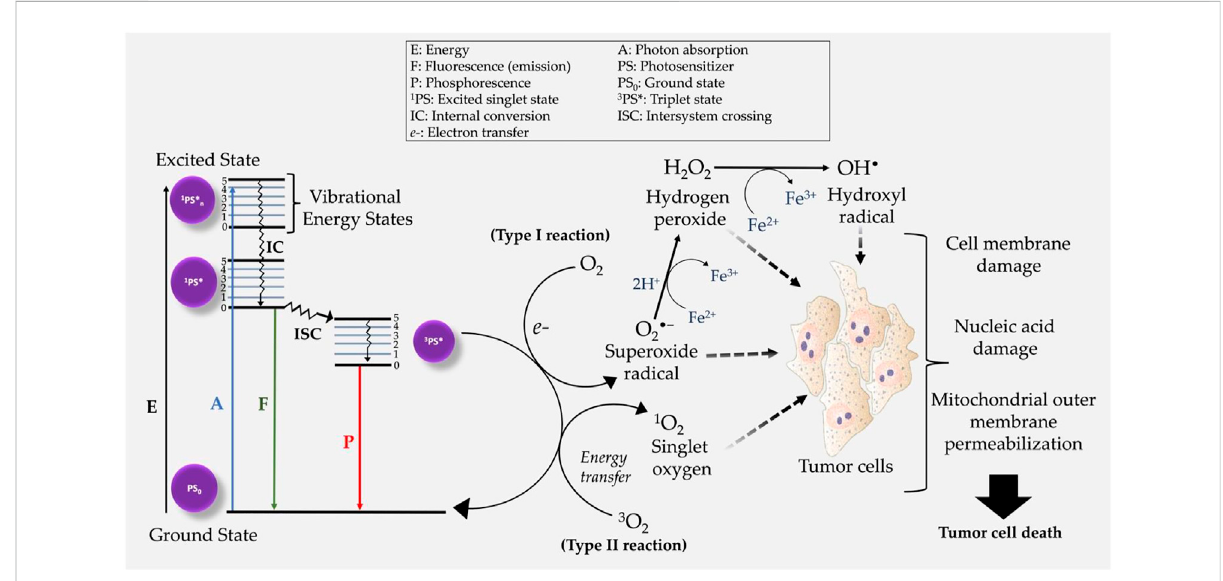
FIGURE 2 Modi fi ed Jablonski diagram demonstrating the mechanism of action of photodynamic therapy. Following the generation of intracellular ROS, tumor cell death is initiated post oxidative stress on several cell